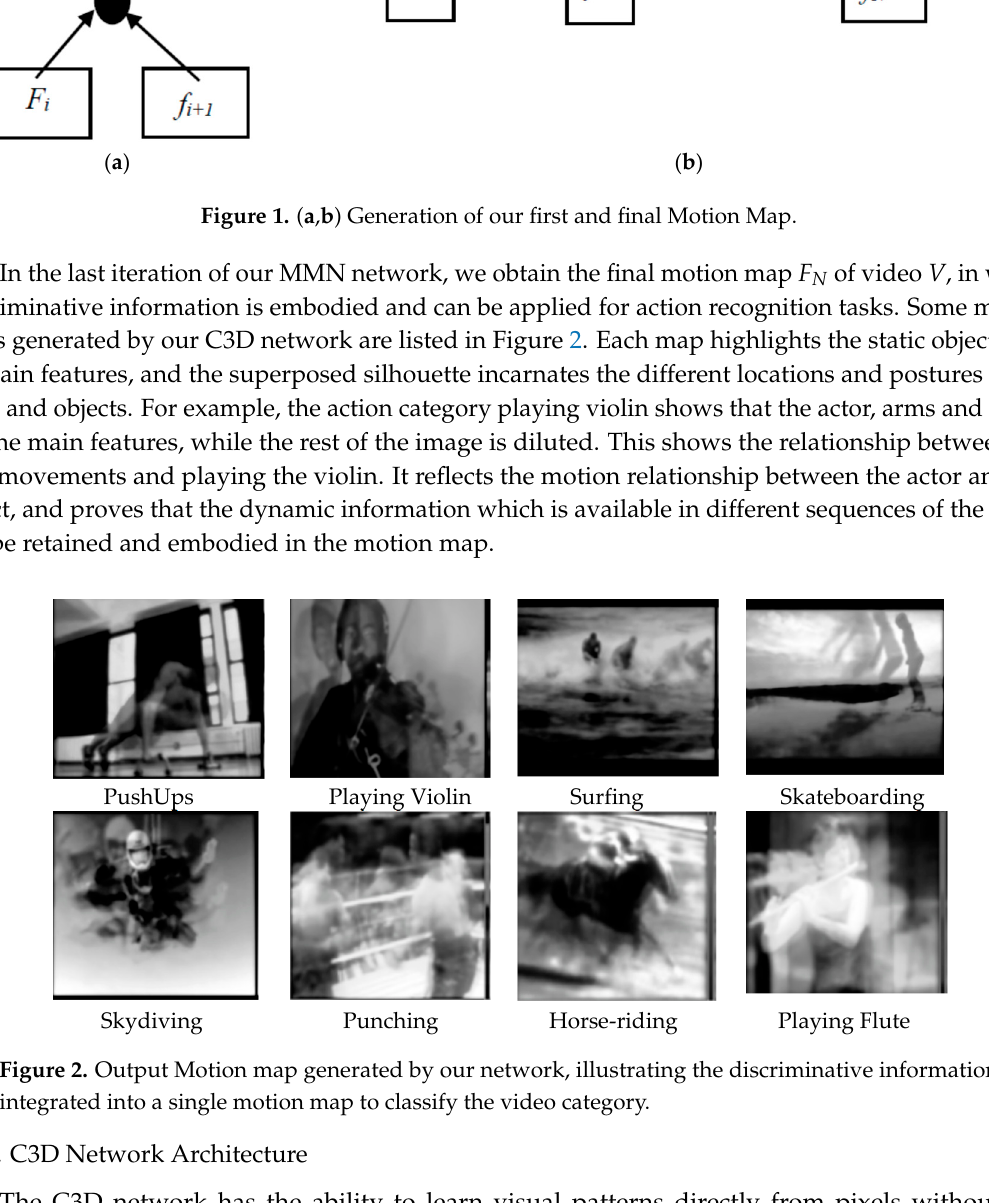
Figure 2. Output Motion map generated by our network, illustrating the discriminative information integrated into a single motion map to classify the video